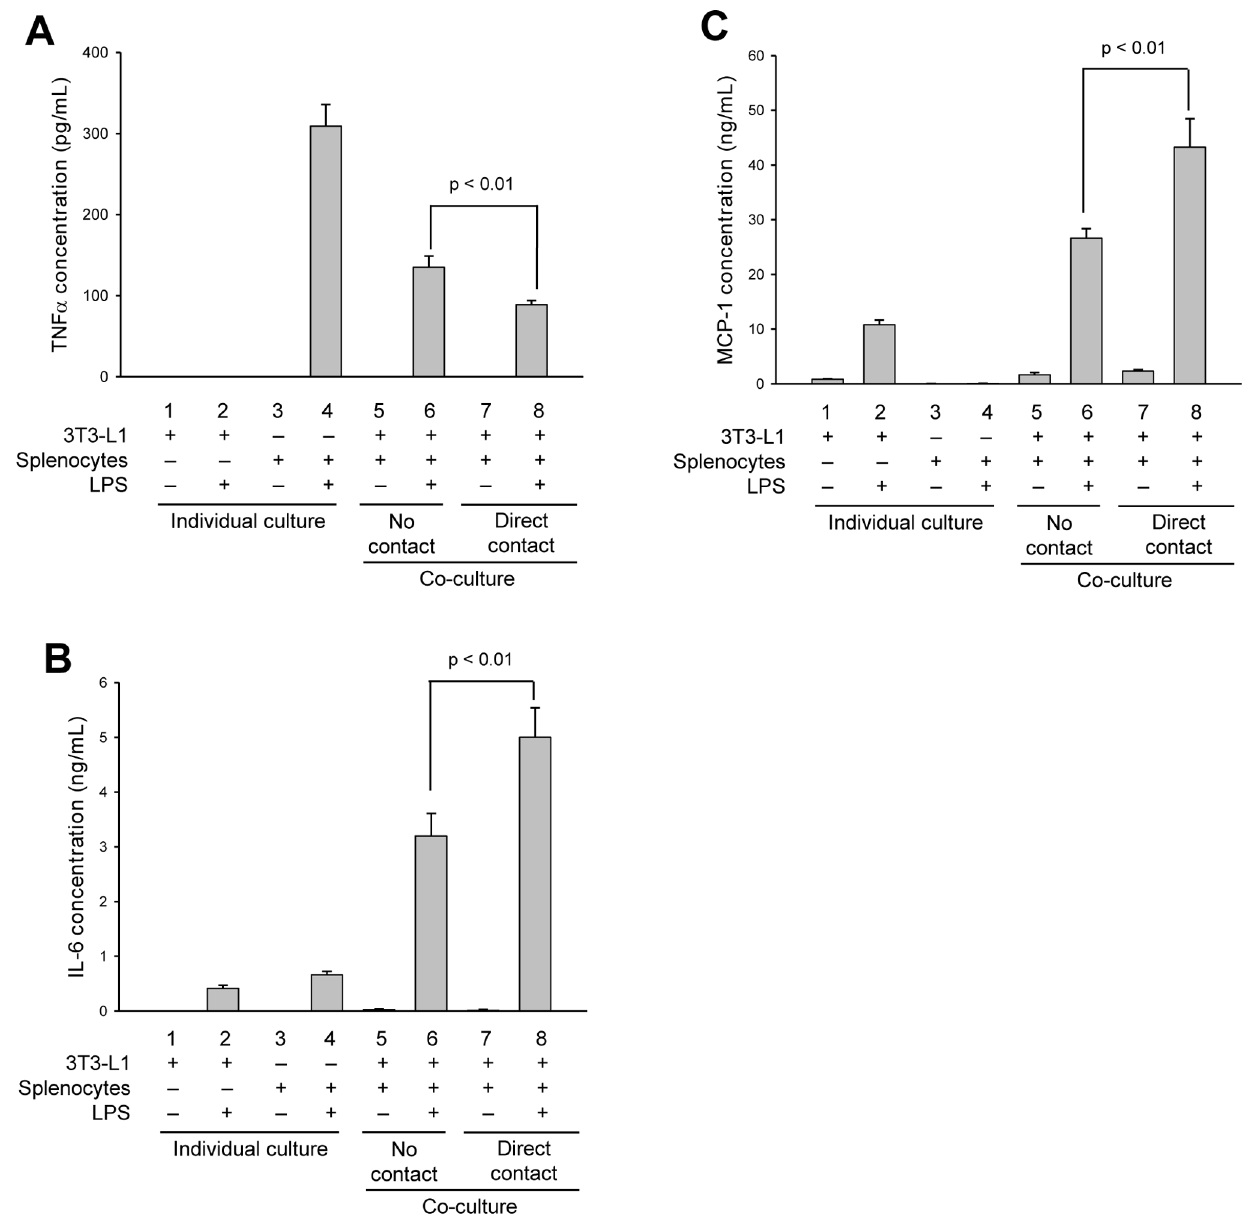
Figure 1. Direct contact between splenocytes and adipocytes alters secreted levels of inflammatory cytokines. Differentiated 3T3-L1 adipocytes (columns 1 and 2) or isolated murine splenocytes (columns 3 and 4) were cultured alone or together with either direct contact (columns 7 and 8) or no contact (cells separated by a 0.4 m m transwell filter system; columns 5 and 6). Cells were additionally incubated in the absence (-) (columns 1, 3, 5 and 7) or presence ( + ) (columns 2, 4, 6 and 8) of LPS (1 m g/mL) for 24 h. Secreted cytokines, TNF a (A), IL-6 (B) and MCP-1 (C), were quantified by capture ELISA. All experimental points were measured in triplicate for calculation of means and standard deviations. Comparison between individual cultures, co-cultures with no contact and co-cultures with direct cell-cell contact were calculated using ANOVA and followed by the post-hoc Bonferroni test. A significant effect was accepted when p , 0.05.